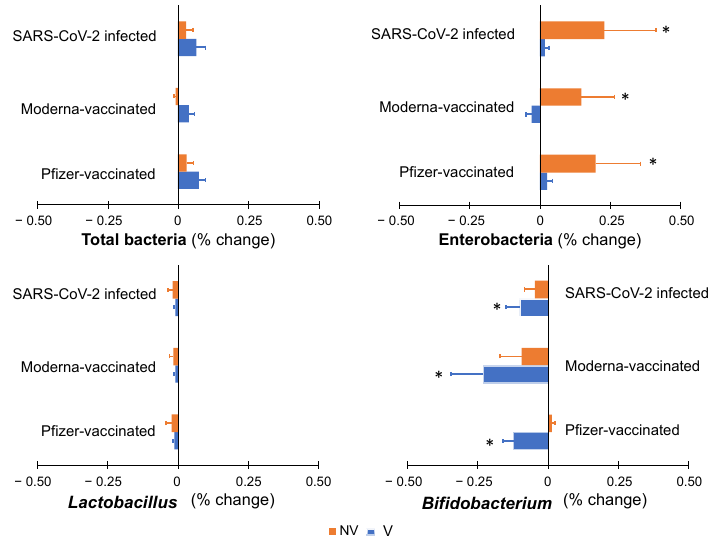
Figure 3. Colonic microbiota profile along simulated colonic fermentation of infants from vaccinated (V) and non-vaccinated or infected (NV) mothers, using as substrates digested breast milk samples in previous gastrointestinal simulation, containing anti-SARS-CoV-2 antibodies as a result of maternal vaccination (with Pfizer or Moderna) or infection. * indicates statistically significant differences with respect to baseline values prior to colonic